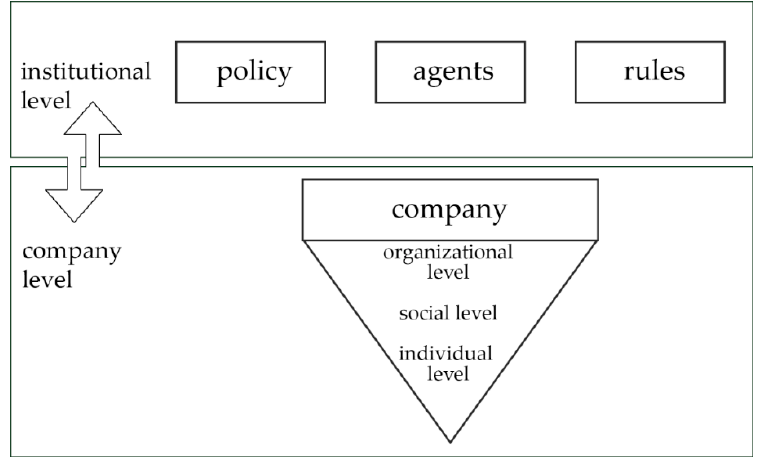
Figure 1. Framework for occupational health and safety (OHS) systems based on the institutional and organizational levels.